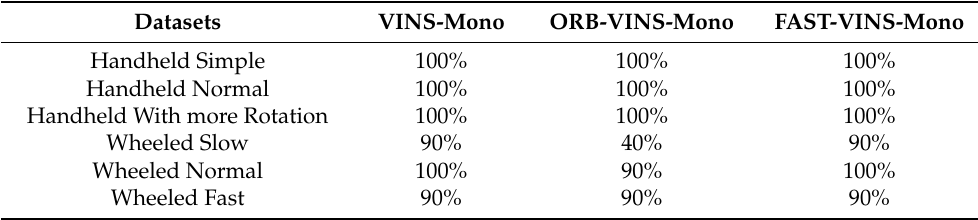
Table 2. Success rate of three different